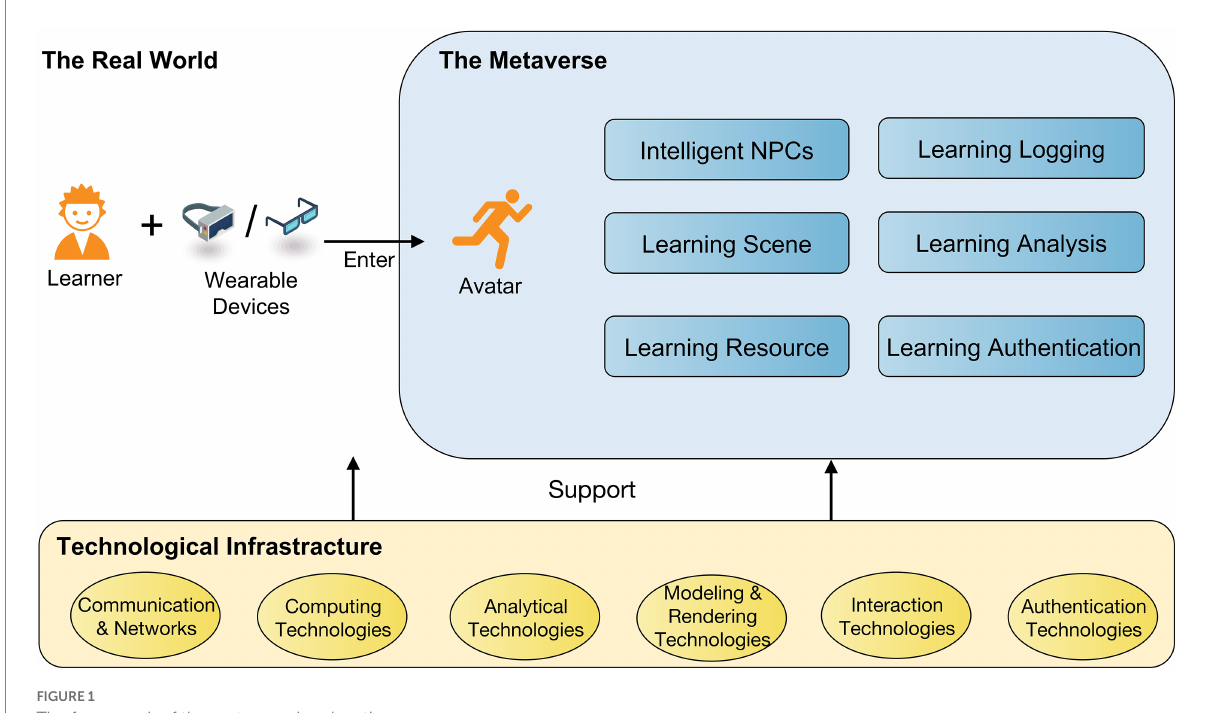
FIGURE 1 The framework of the metaverse in